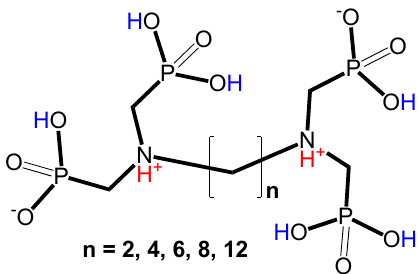
Figure 1. Generic structure of the tetraphosphonate ligands in the neutral, zwitterionic form. Various members of this family have been used for several applications. A complex of 153 Sm with EDTMP ( n = 2) has been investigated as a potential radiotherapeutic agent for treatment of bone tumors [5]. Hybrid materials of EDTMP and HDTMP ( n = 6) with various alkaline ‐ earth metal ions have been used as metallic corrosion inhibitors [6,7]. Coordination polymers with HDTMP have shown gas uptake properties, including a breathing behavior and NH 3 adsorption [8,9].